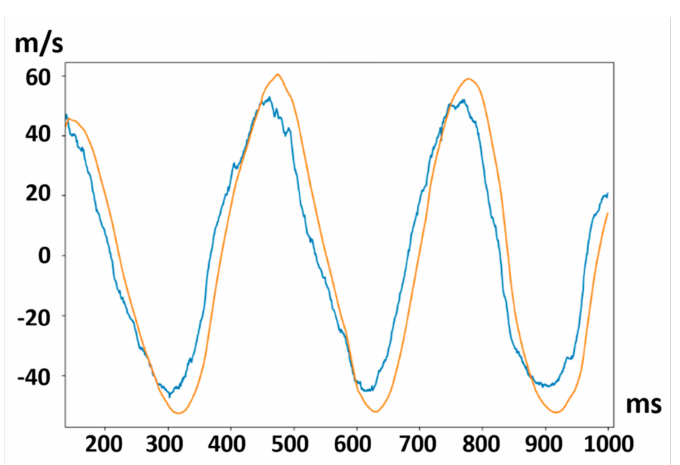
Figure 6. Output response with EKF of 1 layer.